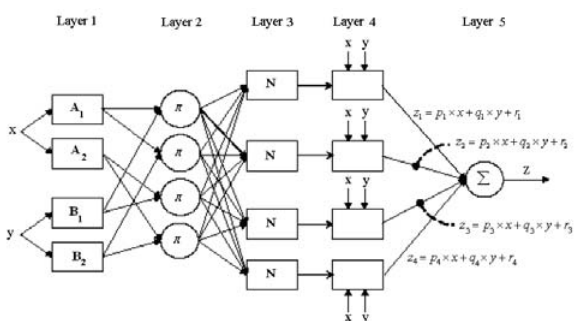
Fig.3 The schematic of ANFIS model structure 1st, 2nd and 5th layers are respectively similar to fuzzification, fuzzy operation and defuzzification in FIS. In 3rd layer average rules is computed by Eq. (14); ,...2,1,